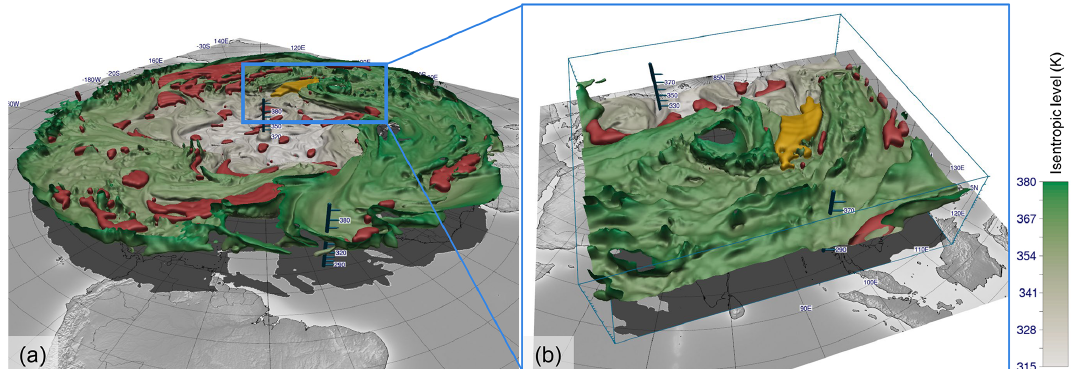
Figure 9. Three-dimensional visualizations of the dynamical tropopause (defined by the 2PVU threshold), which is shaded by isentropic height. Red and yellow are the identified anomalies. The yellow one is emphasized for the case study later on. (a) The entire Northern Hemisphere is visualized; (b) focused view of southeastern Asia, which is investigated in the case study in Sect. 7. Displayed in both panels is the ERA5 reanalysis on 24 July 2015, 00:00 UTC.